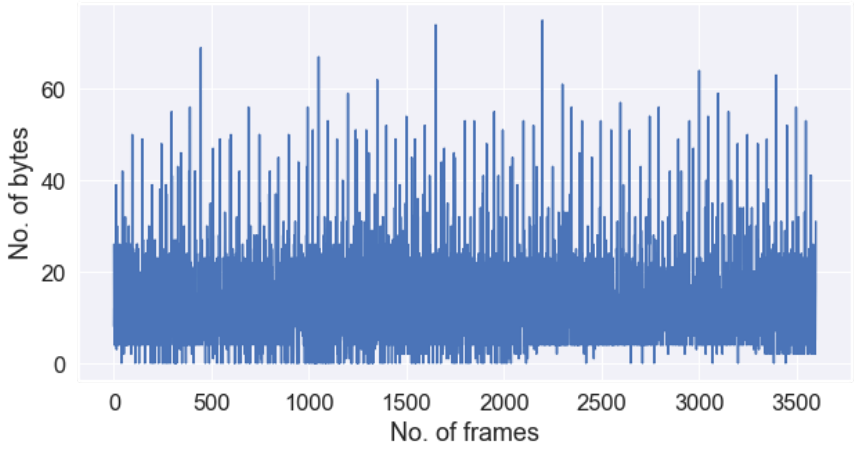
Figure 28b. I/O write requests S2.4.